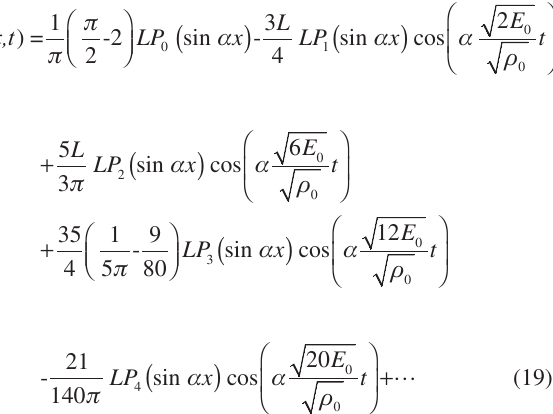
Figure 1 Displacement pattern for modifi ed sawtooth wave input.